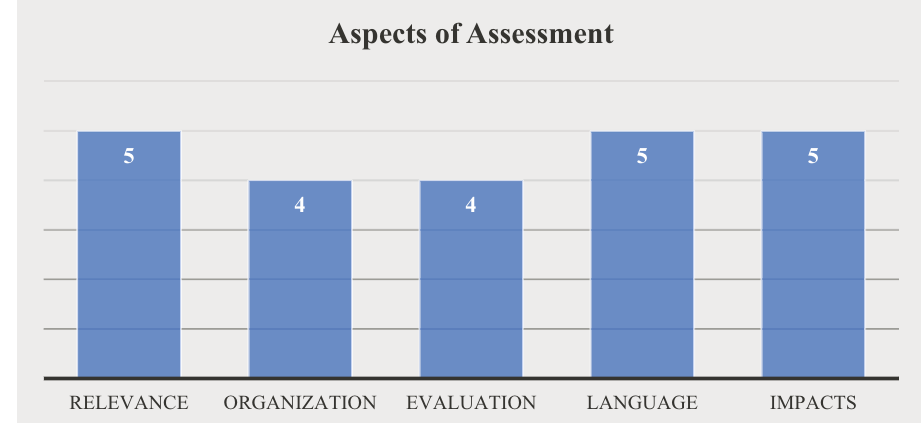
Figure 4: The results of the assessment of the prototype by medical professionals.